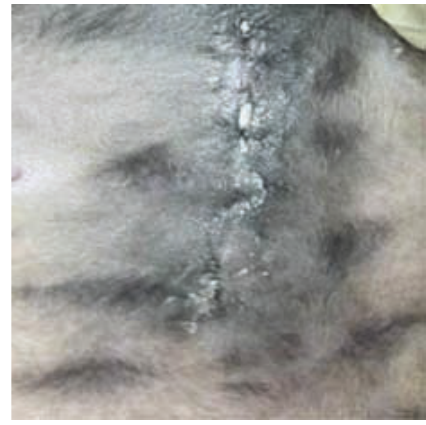
Fig. 5. Surgical wound one week post